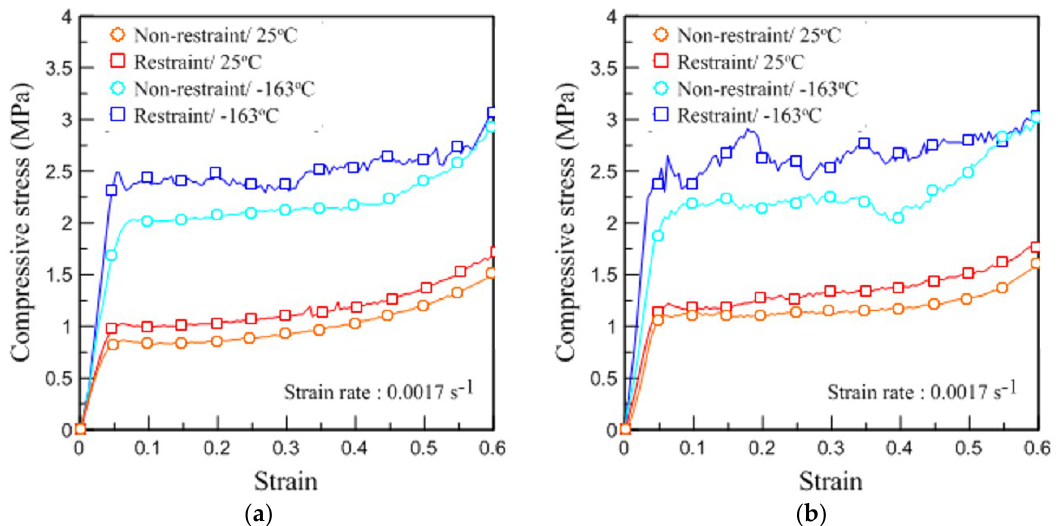
Figure 10. Compressive stress–strain curves for ( a ) pure PUF and ( b ) RPUF according to the environmental conditions of the restraint system.